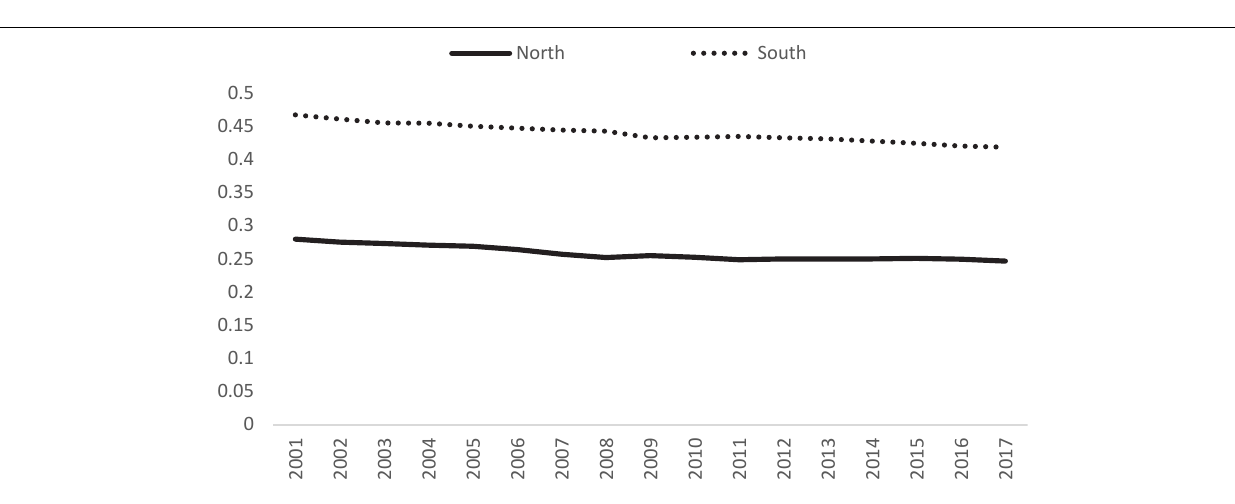
FIGURE 3 | Gini coefficients for the North and South, 2001 to 2017. Source: Authors’